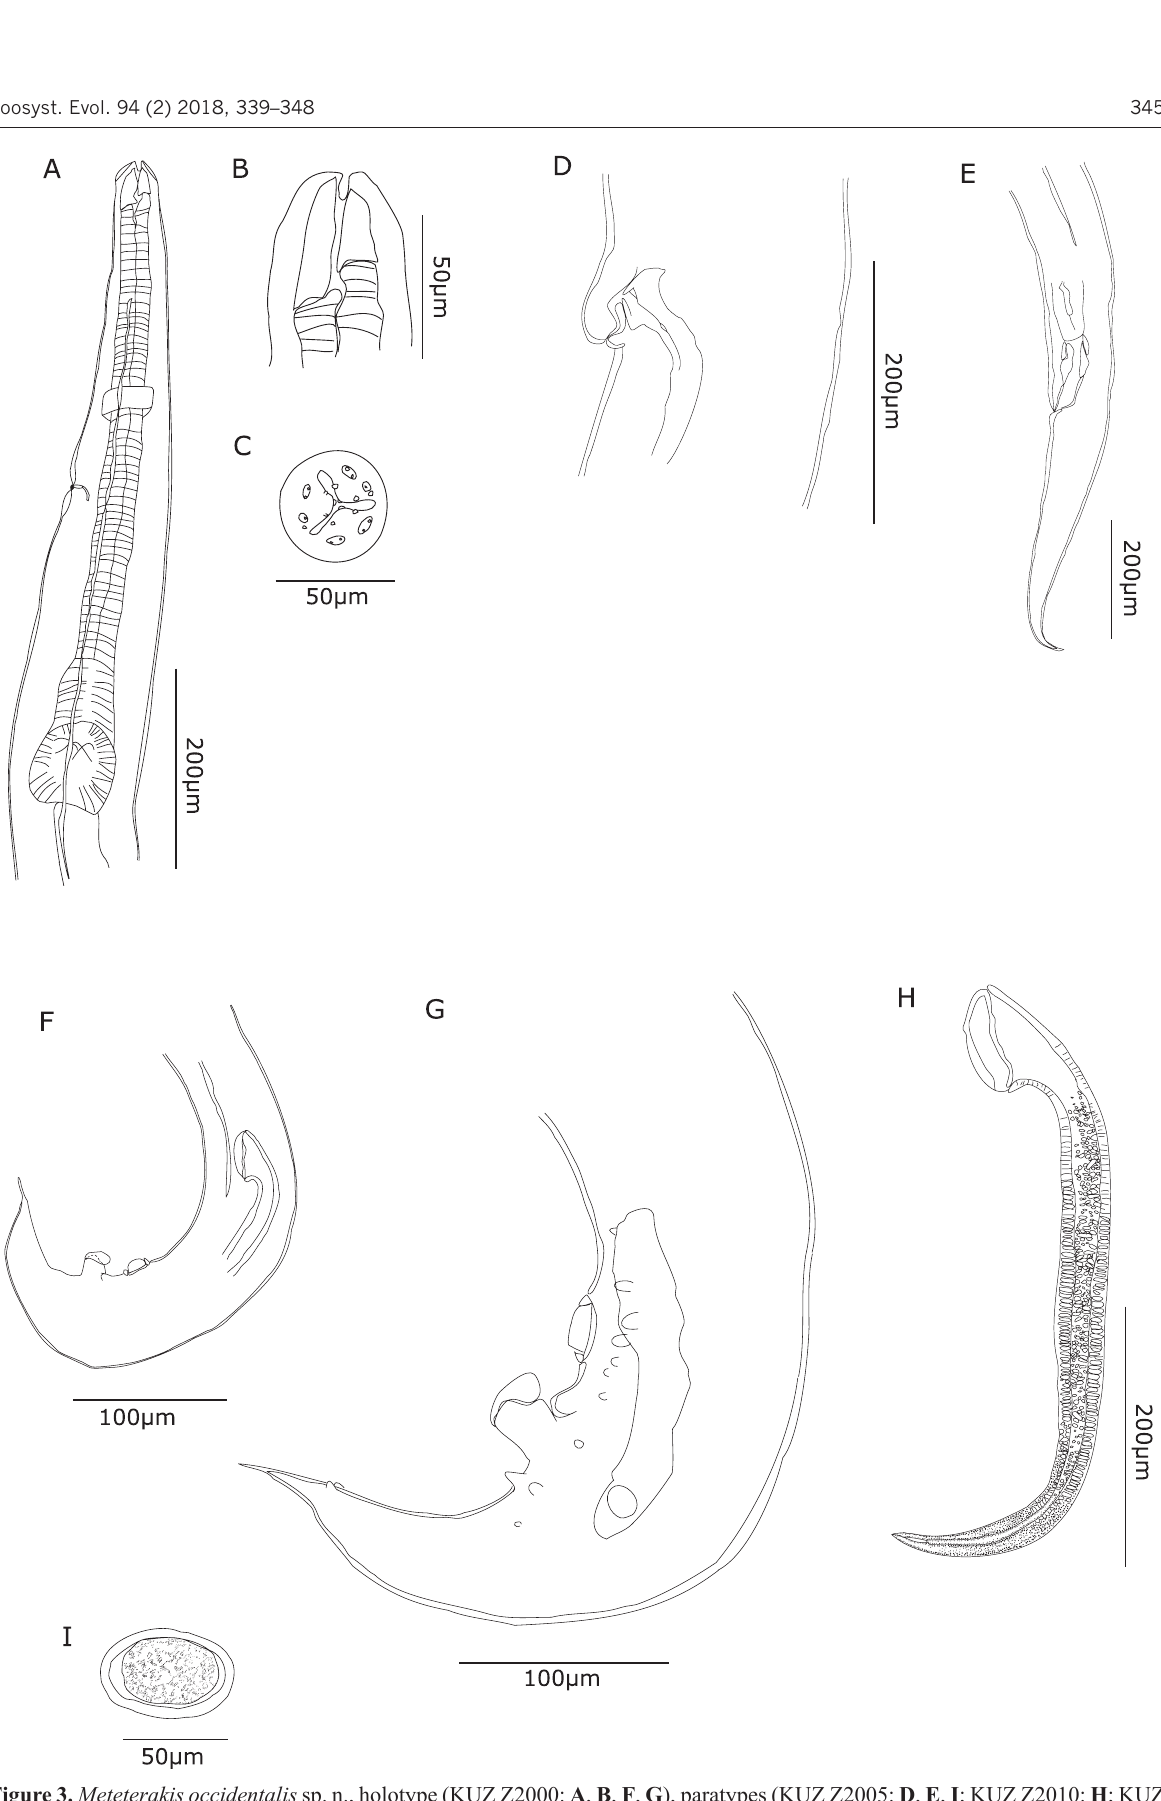
Figure 3. Meteterakis occidentalis sp. n., holotype (KUZ Z2000: A , B , F , G ), paratypes (KUZ Z2005: D , E , I ; KUZ Z2010: H ; KUZ Z2013: C ). A anterior region, lateral view; B pharynx, lateral view; C anterior end, apical view; D vulvar area of female, lateral view; E caudal region of female, lateral view; F caudal region of male, lateral view; G caudal papillae arrangement of male, lateral view; H spicule; I